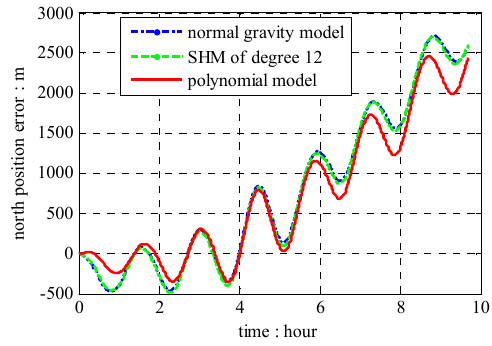
Figure 13. Position errors of north components.